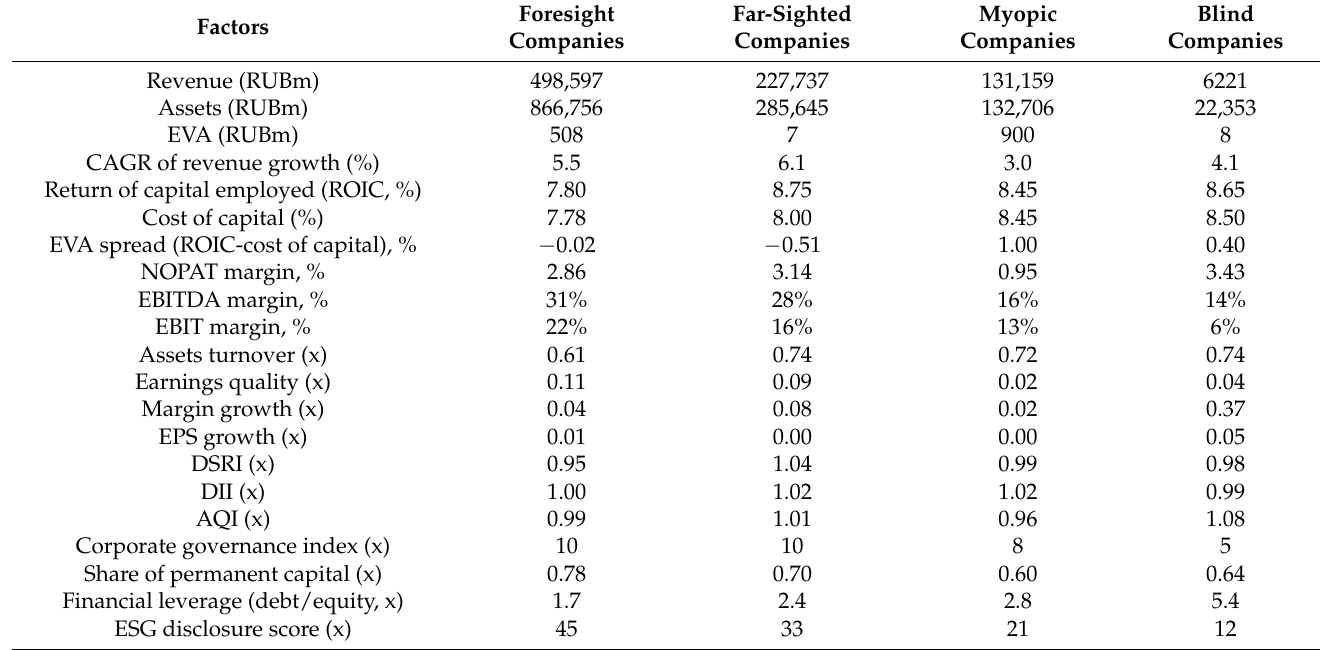
Table 4. Key median characteristics of companies by rating of relative long termism